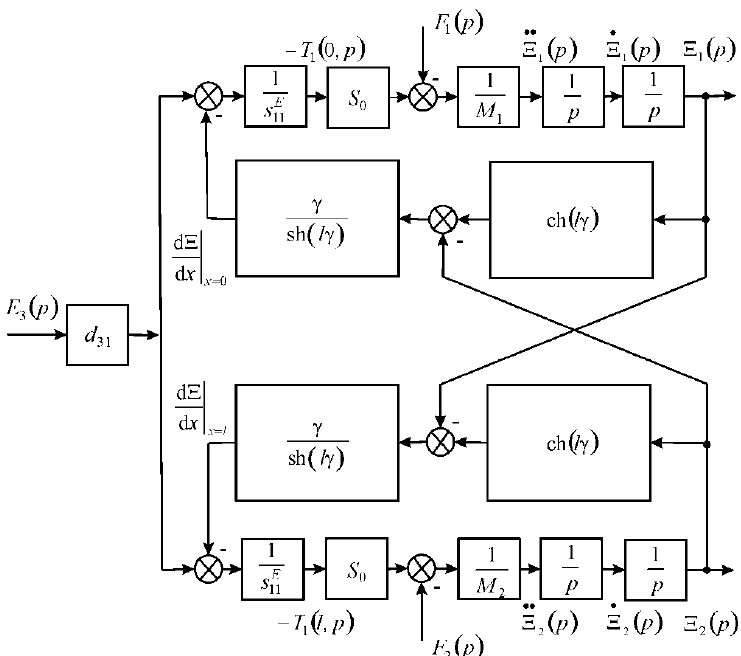
Figure 5. Parametric structural schematic diagram of the multilayer piezoactuator for transverse piezoeffect with voltage control.